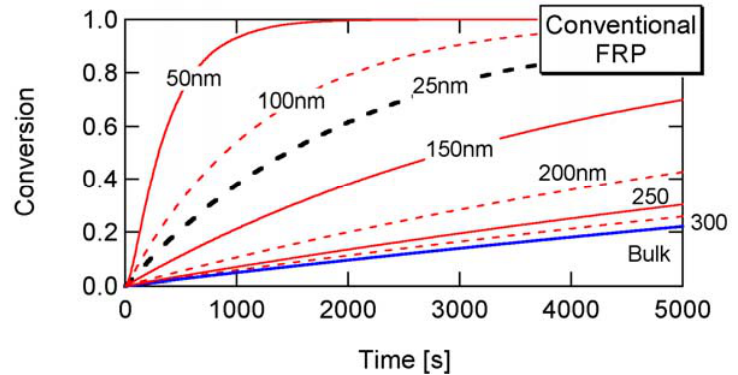
Figure 14. Conversion development of the conventional nonliving free-radical polymerization (FRP), whose kinetic parameters are the same as RAFT-11, except that the RAFT agent is not used